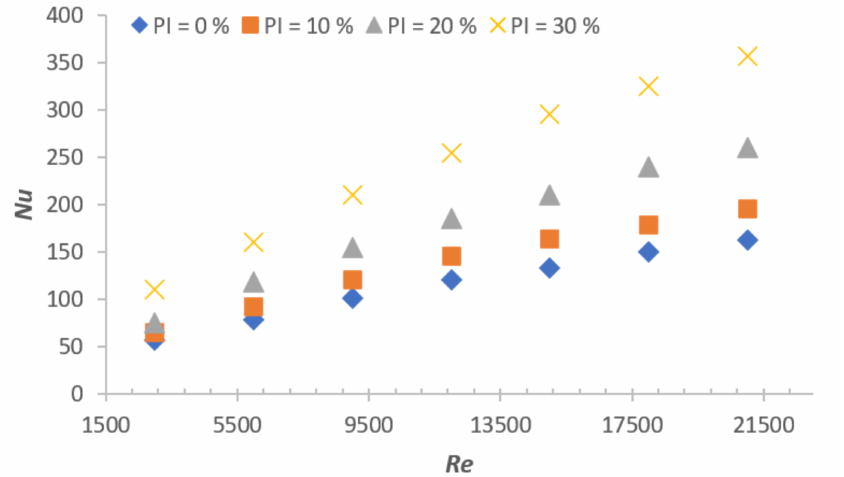
Figure 4. Variation of Nu with Re